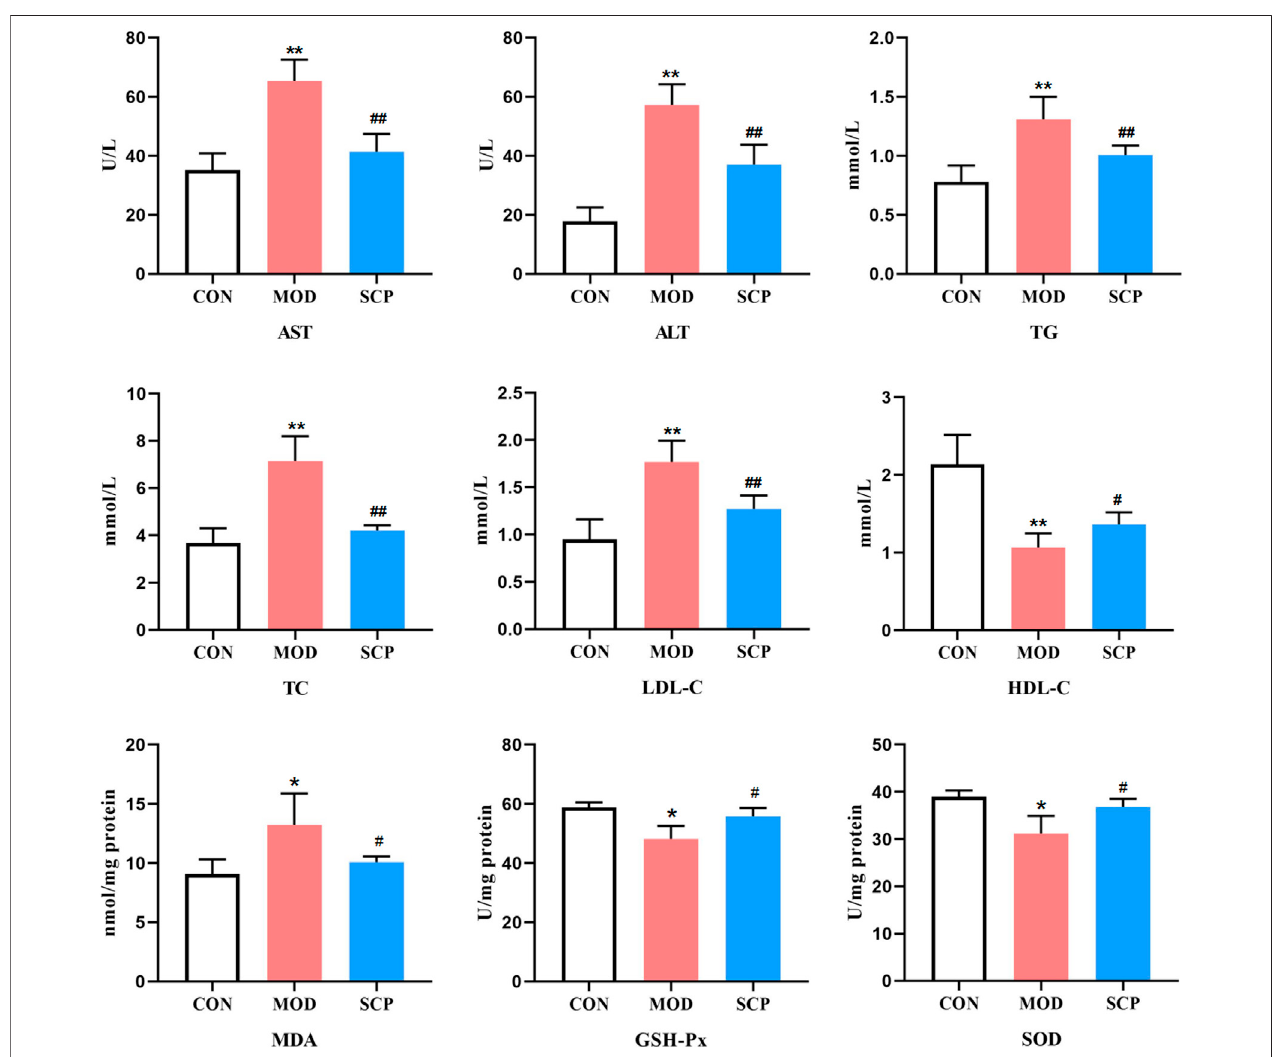
FIGURE 4 | Effects of SCP on the AST, ALT, TG, TC, LDL-C, and HDL-C levels in serum, the MDA level, and GSH-Px and SOD activities in the liver tissue. All the values were expressed as means ± standard deviation; compared with the CON group, * p < 0.05, ** p < 0.01; compared with the MOD group, # p < 0.05, ## p < 0.01.